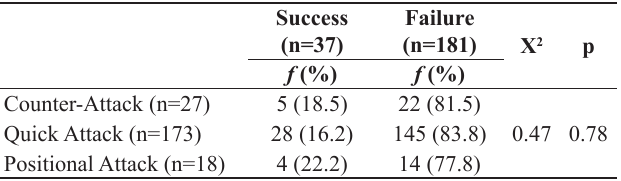
Table 4. Association between different offensive methods and se- quence outcome.